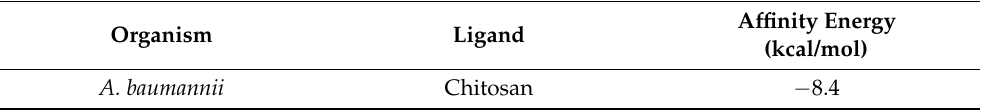
Table 2. Molecular docking results for complexes between chitosan and the target of A. baumannii